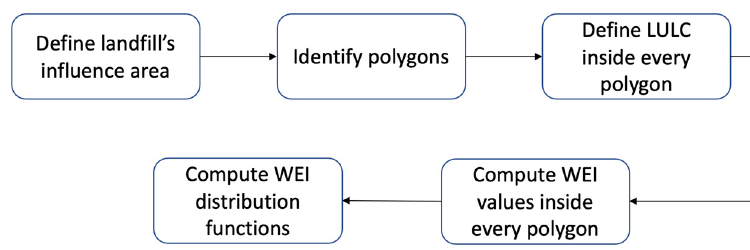
Figure 1. WEI computation methodology flowchart